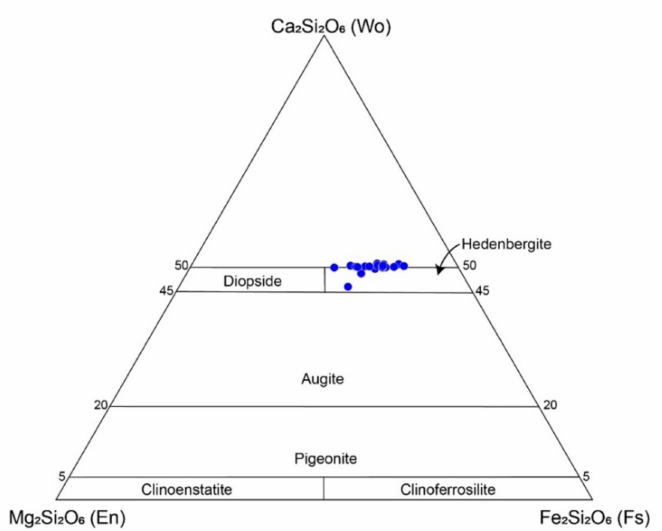
Figure 4. Ca–Mg–Fe clinopyroxene classification diagram after [17].